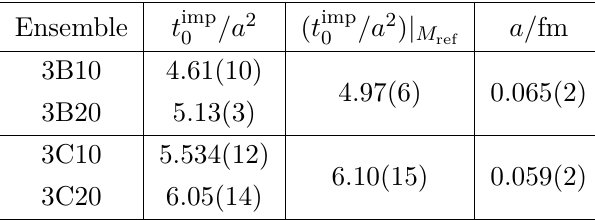
Table 3 . Summary of the quantities entering in the scale setting of the “B” and “C” ensembles, which are the new ones generated for this work. Following the procedure of ref. [17], we use the clover definition of the energy density of the field strength tensor and apply the improvement of ref. [55]. In addition, we interpolate to the reference mass, M = 420 MeV, and calculate the value ref of the lattice spacing in physical units using eq.